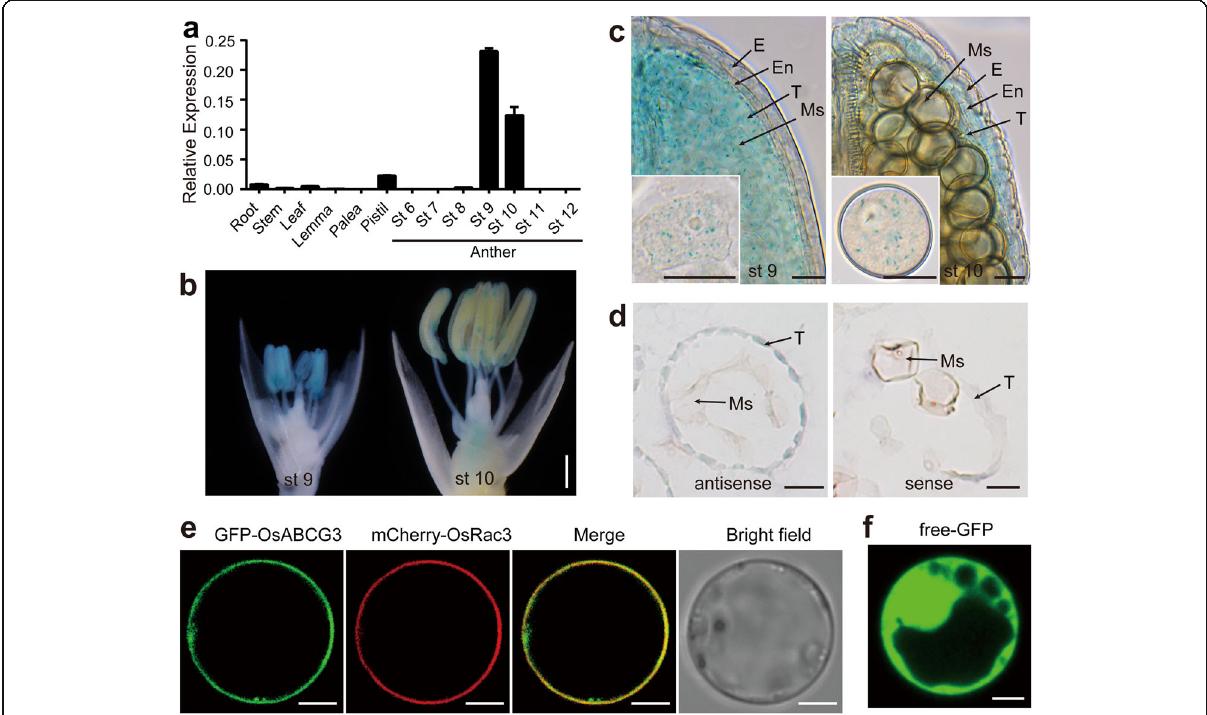
Fig. 3 Expression pattern analysis of OsABCG3 and subcellular localization analysis of OsABCG3 protein. a Expression pattern of OsABCG3. Anthers were collected at different developmental stages (St 6 – 12). Pistils and other tissues were harvested from plants at heading stage. The expression levels were determined by qRT-PCR. OsACTIN1 was used as internal standards. Data are shown as means ± SD ( n = 3). b-c GUS staining of the OsABCG3 pro : GUS transgenic plant. The spikelets with the palea and lemma removed ( b ), and cleared mounted anther and microspores ( c ) were showed respectively. d In situ hybridization of OsABCG3 antisense and sense probes with the WT anther sections, respectively. e, f Subcellular localization of OsABCG3-GFP fusion protein. The fusion protein GFP-OsABCG3 was co-expressed with mCherry-OsRac3, a plasma membrane marker, by transient expression in rice protoplasts (e) . The construct 35S:GFP was transformed as a control (f) . Localization of the fluorescence-tagged proteins was examined by confocal microscopy. Scale bars =1 mm ( b ); 25 μ m ( c, d ); 5 μ m ( e, f